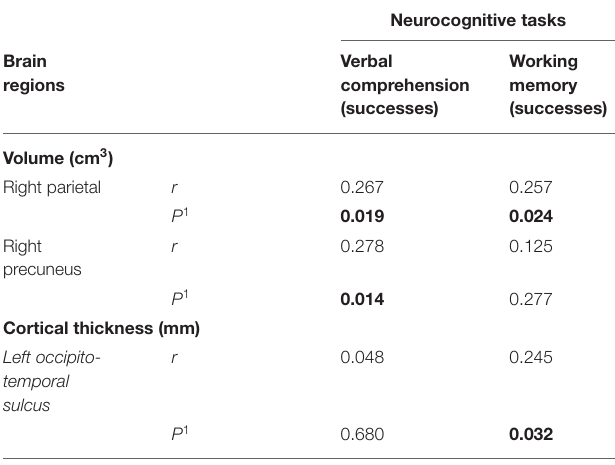
a P-values for correlations between brain structure and neurocognitive development. P < 0.05 are highlighted in bold. r, Pearson correlation coefficient.